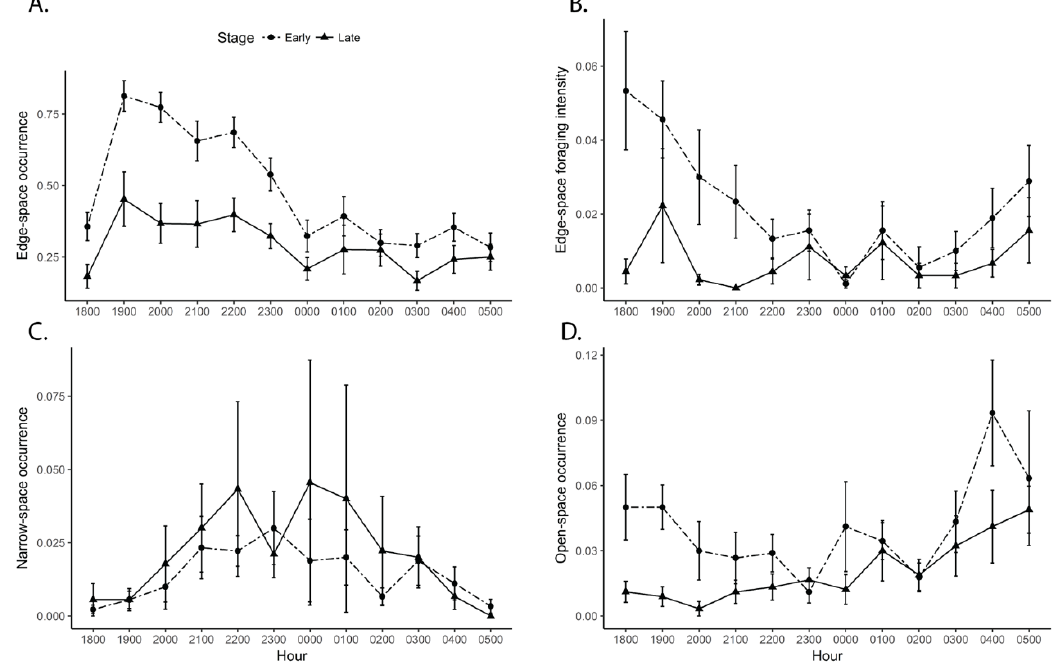
Figure 3. Bat activity by rice growth stage recorded at rice level during the 2015 wet season. Average ( ± standard deviation) edge-space occurrence ( A ) and foraging intensity ( B ), narrow-space occurrence ( C ), and open-space occurrence ( D ) by hour and rice growth stage (Early = dashed line, Late = solid line). Note differences in scales.